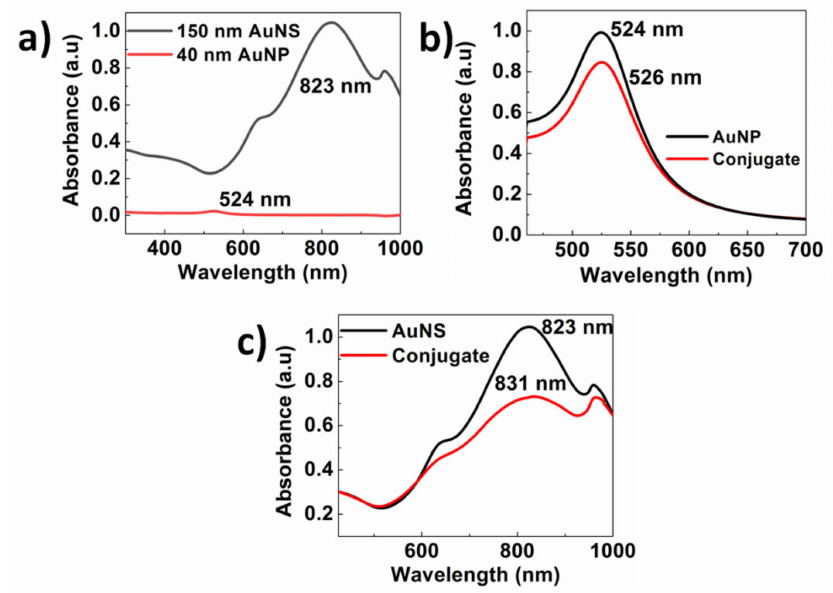
Figure 1. ( a ) UV–vis spectra of carboxyl-coated 150 nm gold nanoshells and 40 nm gold nanoparticles at equal particle number. ( b ) UV–vis spectra of 40 nm gold nanoparticles before and after conjugation. ( c ) UV–vis spectra of 150 nm gold nanoshells before and after